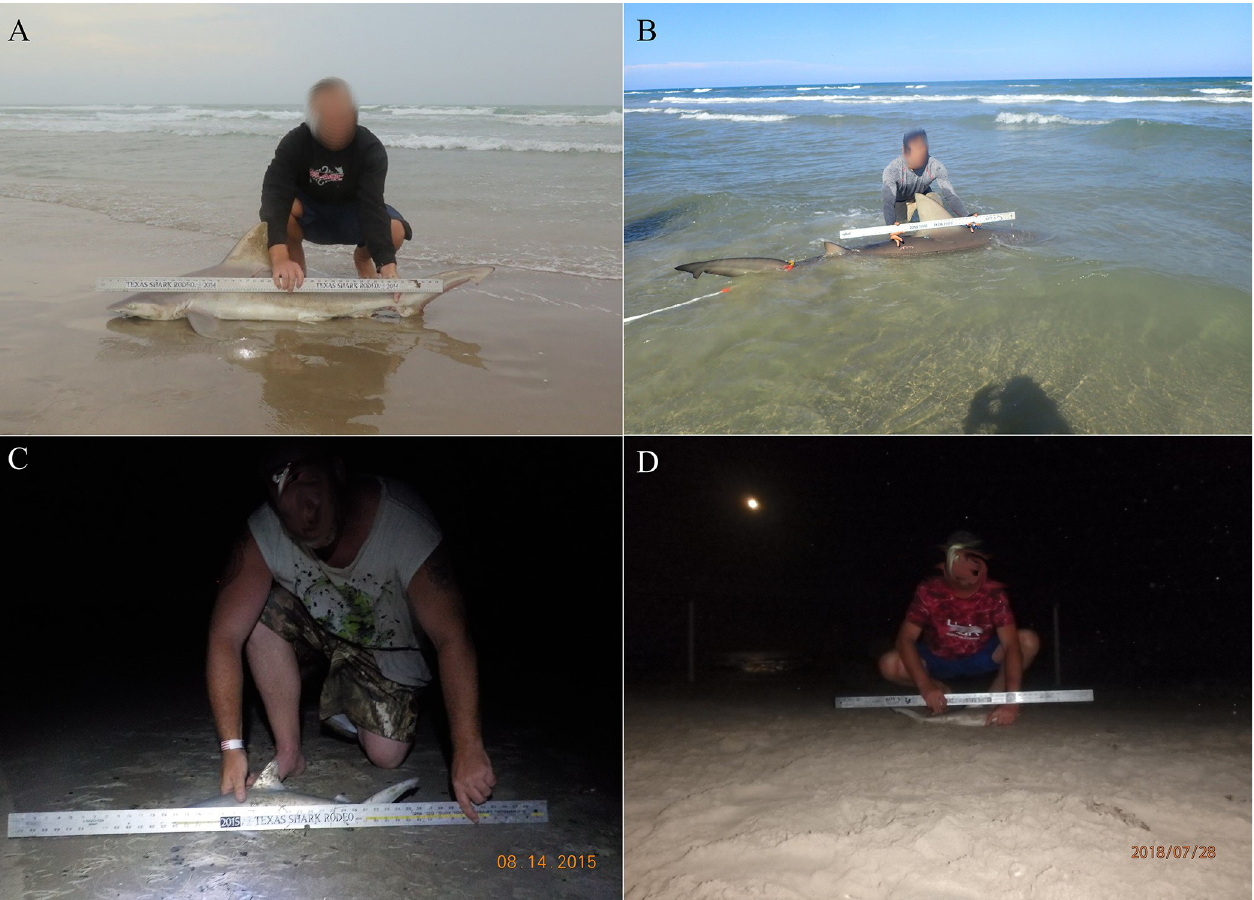
Fig 3. Shark photographs submitted by participants in the TSR where distinguishing characteristic were visible (A) and photographs that were classified as unknown (B-D). A) Confirmed sandbar shark with visible characteristics. B) Angler identified shark as bull shark, but identification could not be confirmed because shark was underwater. C) Angler identified shark as blacktip shark, but identification could not be confirmed because ruler covered most of the shark’s body. D) Angler identified shark as a sandbar shark, but species could not be identified because of photo scale, blurriness, and shark’s head covered by angler’s